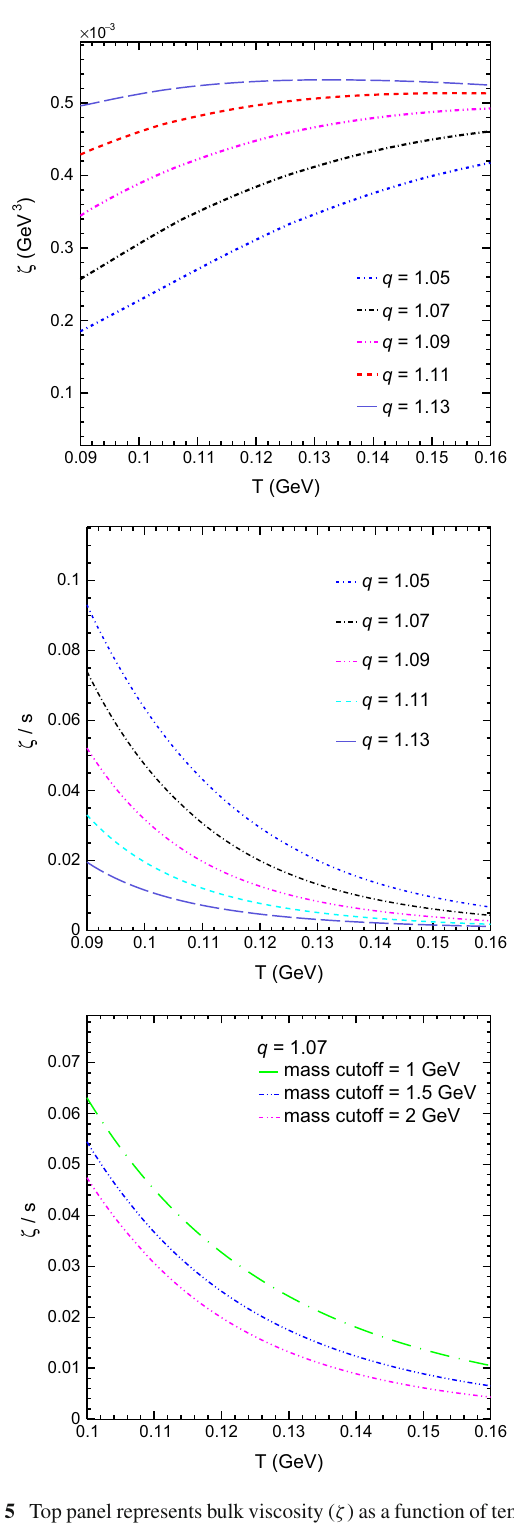
Fig. 5 Top panel represents bulk viscosity ( ζ ) as a function of temper- aturefordifferent q -values.Middlepanelshows ζ/ s versustemperature for different q -values. Lower panel presents the variations of ζ/ s with respect to temperature at q = 1 . 07 for various upper mass cutoff of hadron resonance